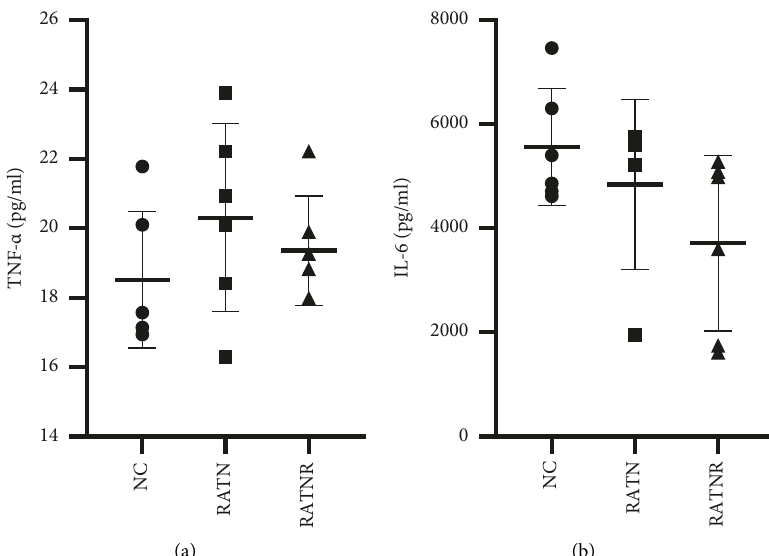
Figure 6: Triple culture supernatant cytokine concentration comparing the conditioned media exposed to healthy (NC), RA treatment na¨ıve (RATN), and RA treatment-nonresponding (RATNR) patients’ serum. (a) TNF- α ; (b) IL-6. Statistical analysis: one-way ANOVA. n � 6 per group. Data represented as mean ± SD. TNF- α � tumour necrosis factor- α ; IL � interleukin.